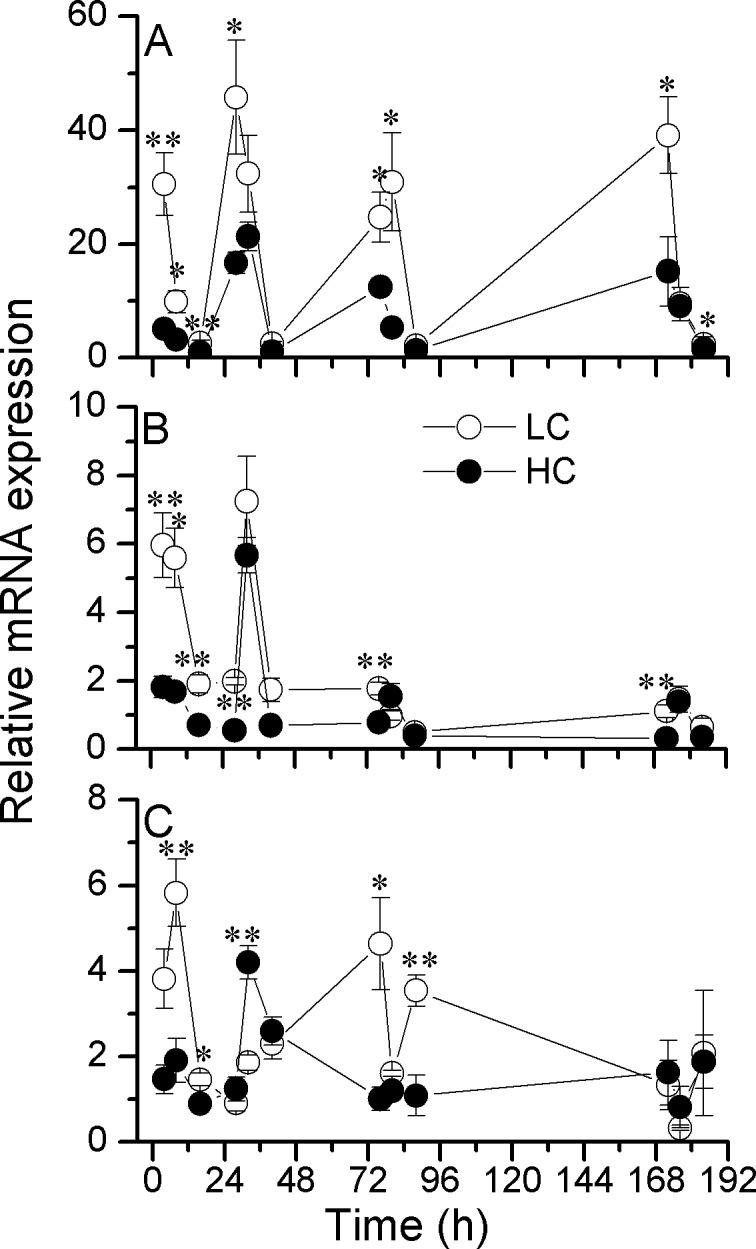
The relative abundances of transcripts for photosynthetic relevant genes.Time series of the relative abundances of transcripts for β-carbonic anhydrase (β-CA; A), fucoxanthin chlorophyll a/c protein, lhcf type (FCP, Lhcf 3; B), ribulose-1, 5-bisphosphate carboxylase/oxygenase large subunit gene (RbcL; C) determined by quantitative real-time PCR (qPCR) of P. tricornutum cells grown at ambient (390 μatm; LC) and elevated CO2 (1000 μatm; HC) levels. Data are presented as means ± SD, n = 3 (triplicate cultures). Two asterisks indicate a significant difference between HC and LC grown cells at p < 0.01, and one asterisk represents a significant difference at p < 0.05.